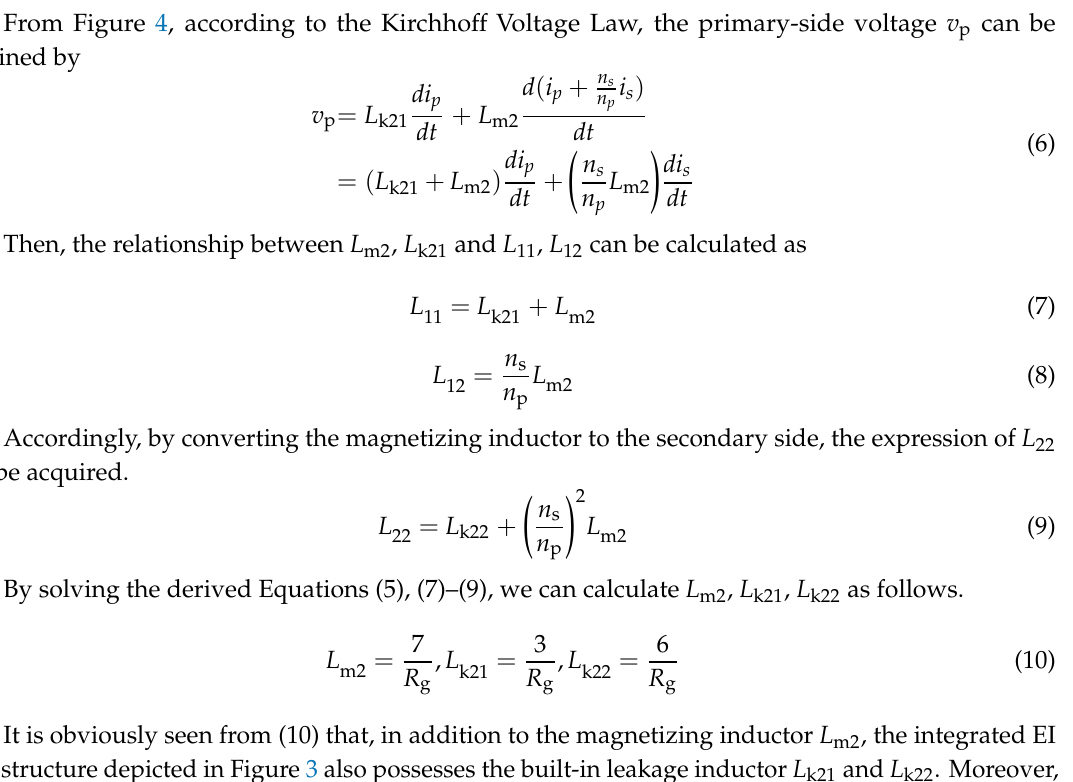
Figure 4. T-model of the transformer T 2 .